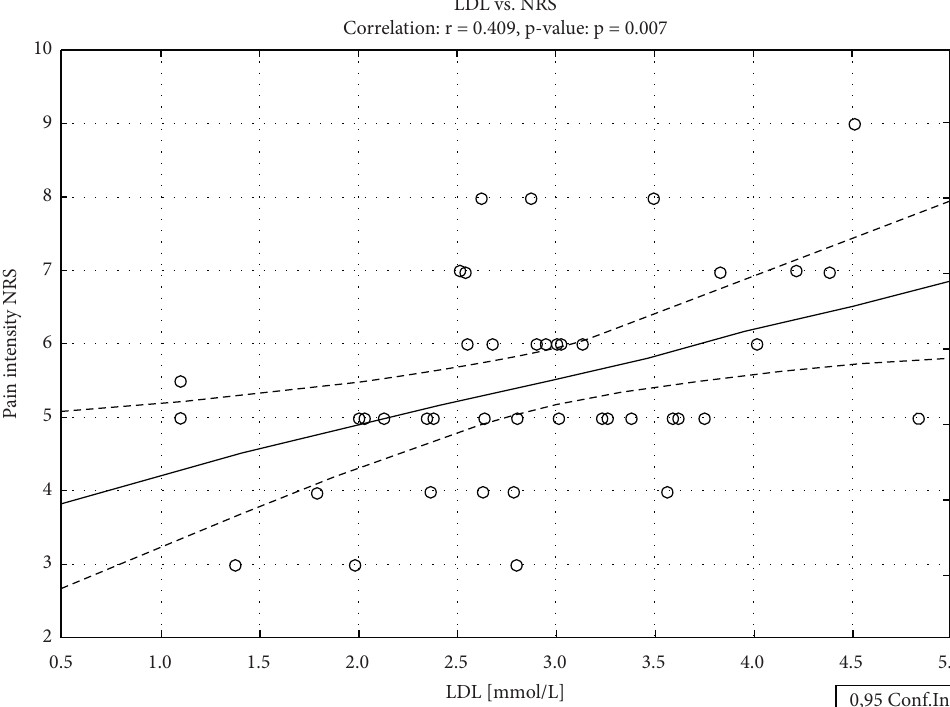
Figure 2: Relationship between pain intensity and LDL cholesterol levels in patients with whom the treating physician has a positive relationship.